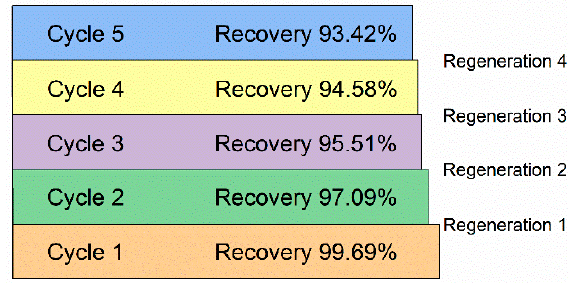
Figure 6. Pb 2+ adsorption performance by 75% GO-SWCNT BPs after four regeneration processes in a 10% ( v / v %) aqueous solution of 2-mercaptoethanol for 24 h. The initial lead concentration was 1